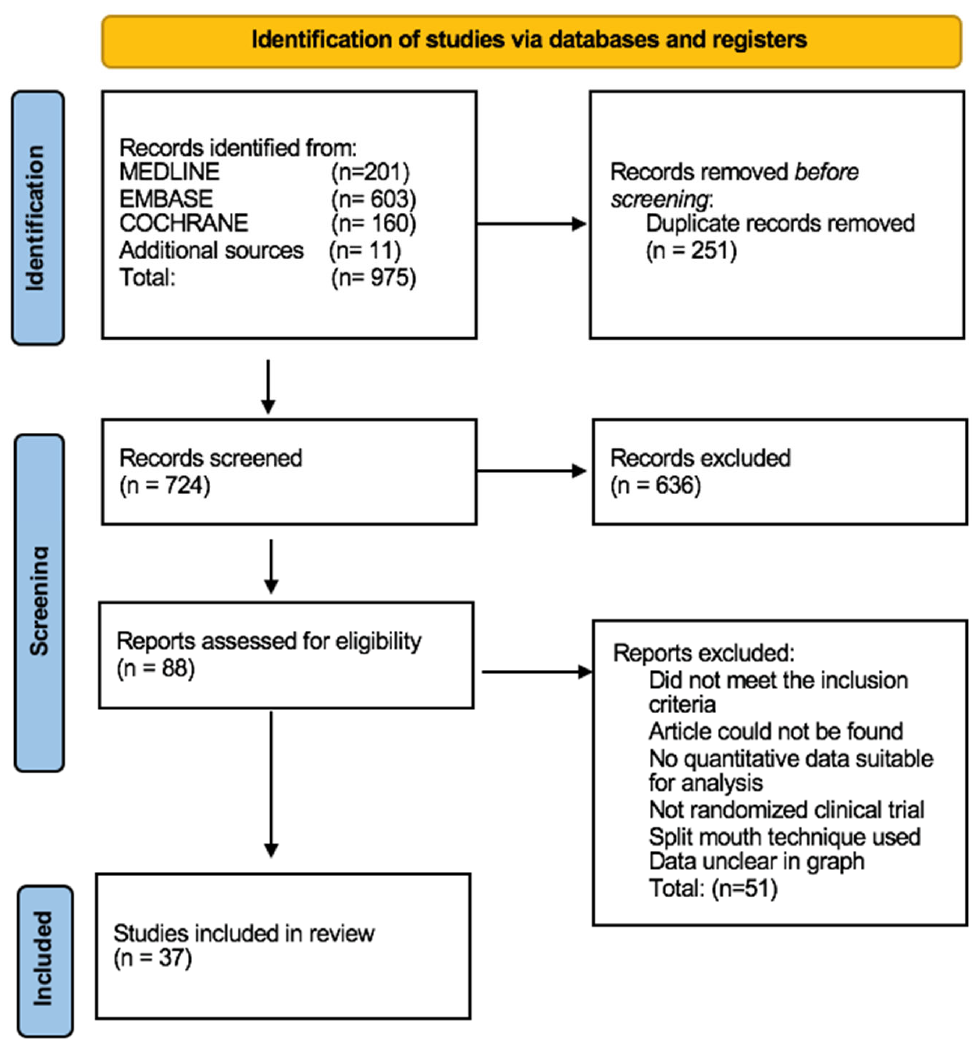
Figure 1. Prisma flow chart.